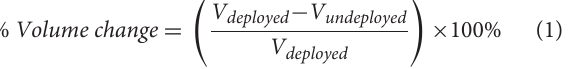
that maintains its ability to pass through a narrow, curved path, at the end of which the CYCLOPS robot is